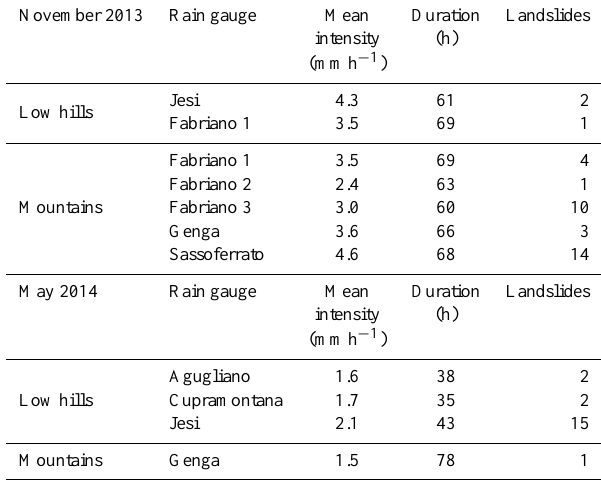
Table 1. Values of rainfall mean intensity and duration registered in each rain gauge and number of paired landslides during the events of November 2013 and May